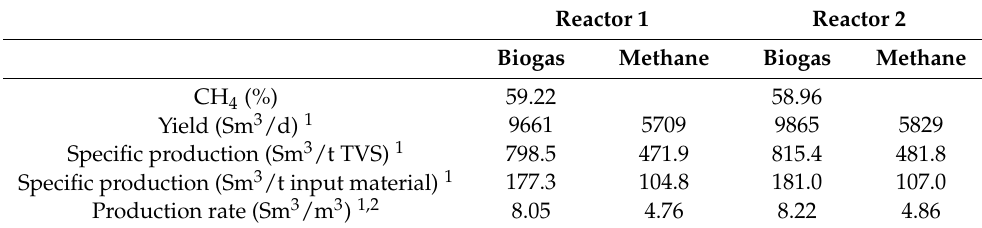
Table 2. Rende AD plant average performances from September 2018 to September